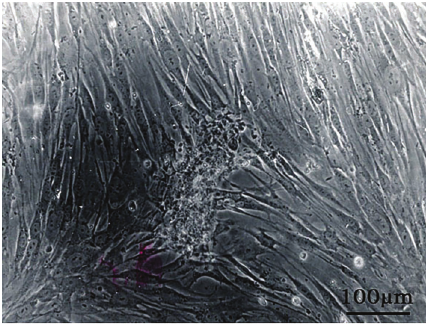
Figure 4. Nebulous extracellular secretions covered fi broblasts induced with 40 m g/mL fi bronectin at 7 days. Phase contrast microscope, (cid:1) 100.